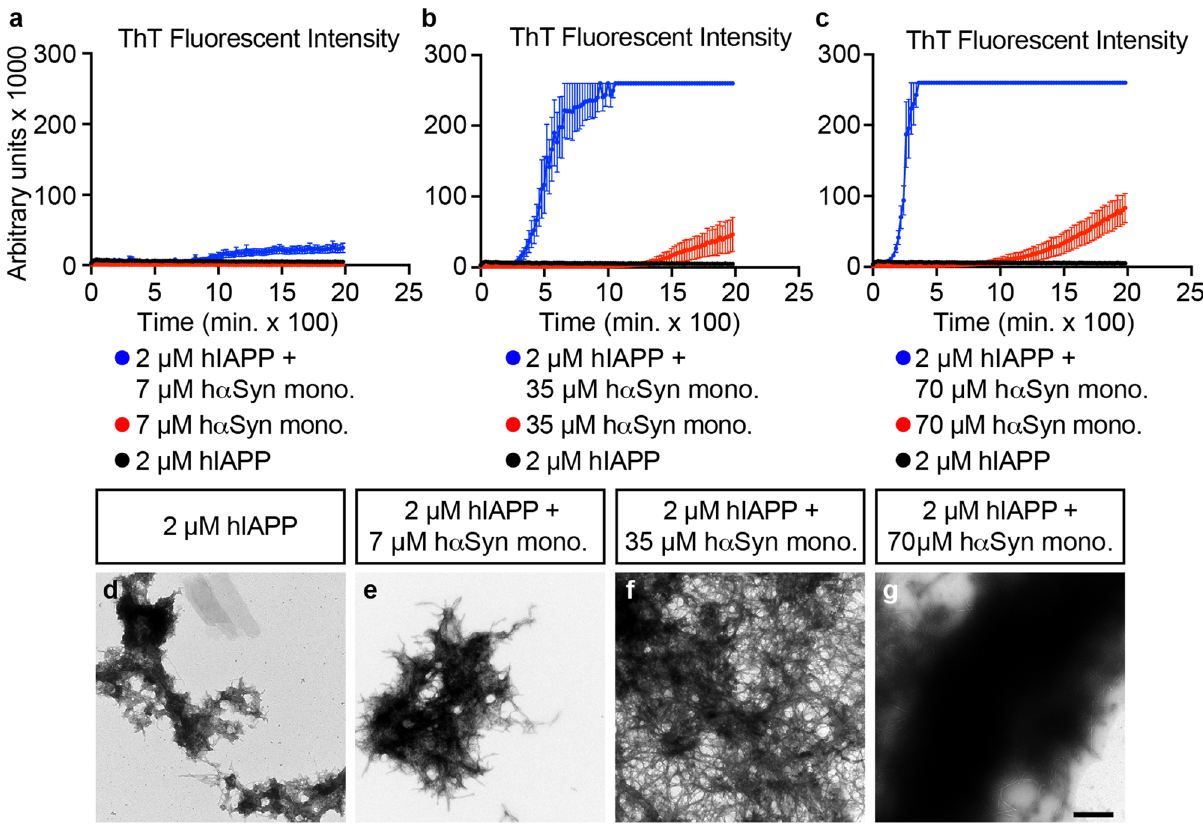
Figure 3. αSyn monomers dose-dependently cross-seed IAPP fibril formation. ( a–c ) Fibril formation ThT curves for 2 µM hIAPP monomers alone (black) and with 7, 35, and 70 µM hαSyn monomers (blue), shown are also curves for 7, 35, and 70 µM hαSyn monomers alone (red). Please note that ( a) is adapted from Fig. 2a but presented with a different scale on the x-axis to allow direct comparison with ThT emissions curves in (